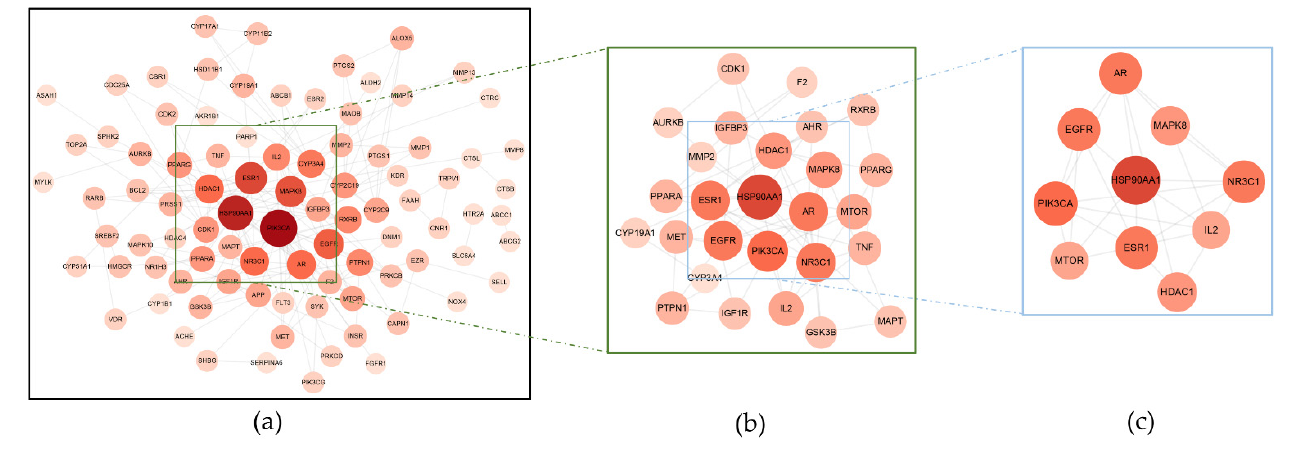
Figure 4. The PPI network visualized by Cytoscape. ( a ) the interaction between 90 overlapping targets; ( b ) the interaction between major targets; ( c ) the interaction between key targets. The larger the node degree value, the darker the color. Table 2. The major targets and their uniport IDs.